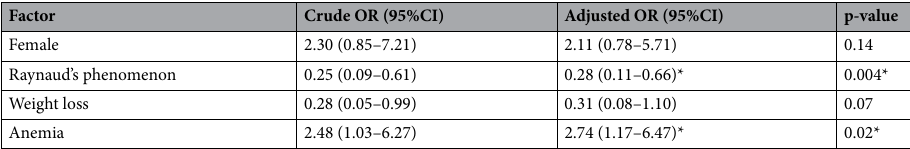
Table 3. Logistic regression analysis of clinical parameter of SSc associated with clinical-subclinical hypothyroidism. CI: confidence interval; OR: odds ratio. *Statistically